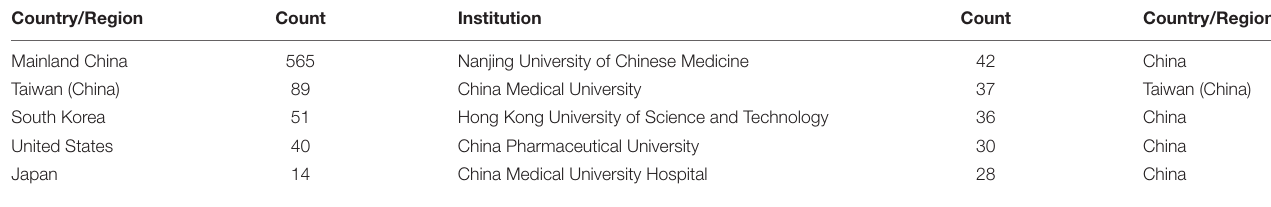
TABLE 1 | The top five countries/regions and institutions in Angelica sinensis research. Country/Region